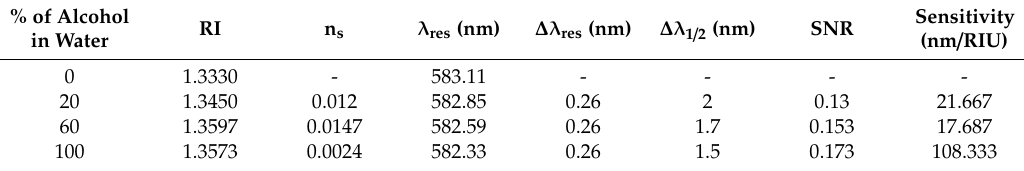
Table 4. Ag–Cu SPR sensor: sensitivity and SNR comparison.